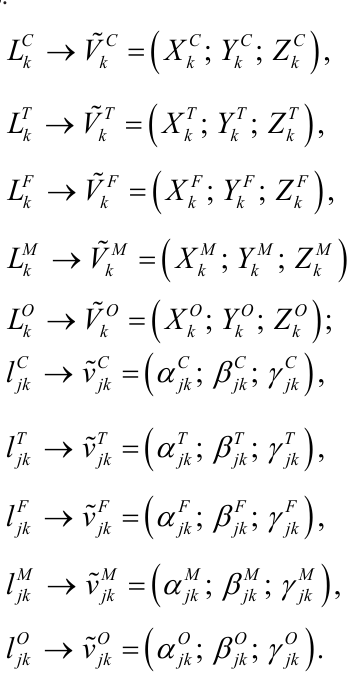
Step 2. Transformation of experts’ linguistic eval-